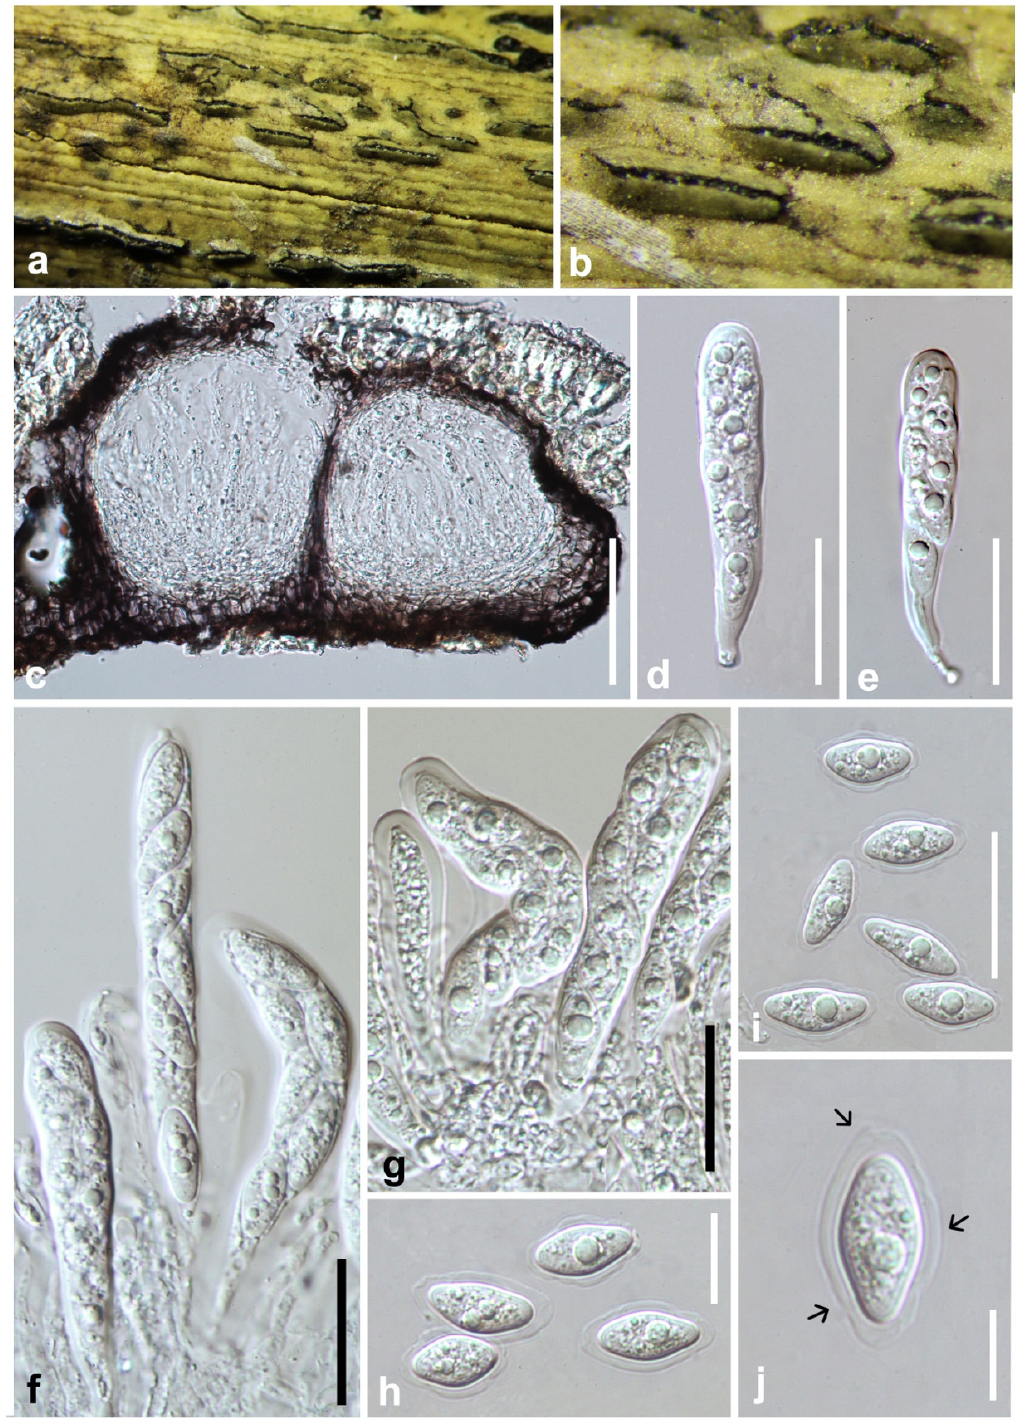
Figure 4. Botryobambusa guizhouensis (HKAS 112600, holotype). ( a , b ) Appearance of ascomata on bamboo. ( c ) Vertical section of ascomata. ( d , e ) Immature asci. ( f , g ) Immature and mature asci. ( h – j ) Hyaline, aseptate ascospores enclosed with mucilaginous sheath. Scale bars: ( c ) = 50 µm, ( d – g ) = 100 µm, ( h , i ) = 20 µm, ( j ) = 10 µm. Sardiniella celtidis Dissan., Camporesi and K.D. Hyde, Fungal Divers 87: 12 (2017) (Figure 5). Index Fungorum number: IF552896; Facesoffungi number: FoF02732. Saprobic on a decaying host. Sexual morph: Ascostromata 210–300 × 275–340 µm ( 𝑥 = 270 × 310 µm, n = 20), dark brown to black, globose, immersed in the substrate, partially